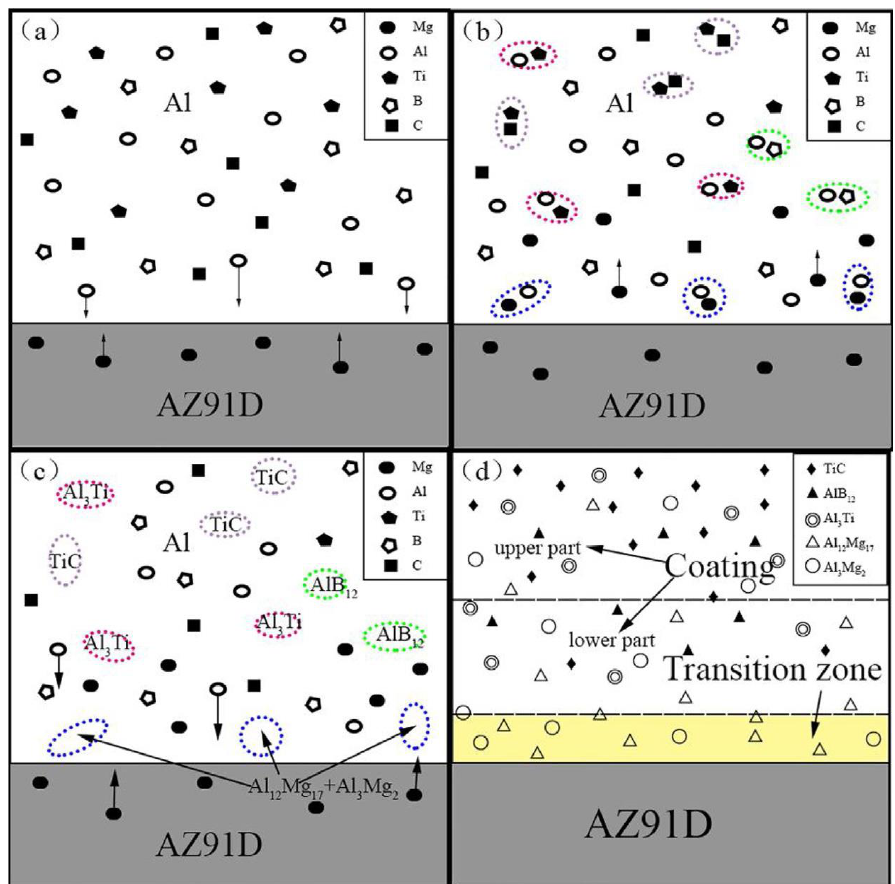
Figure 10: Schematic diagram of compounds [44]